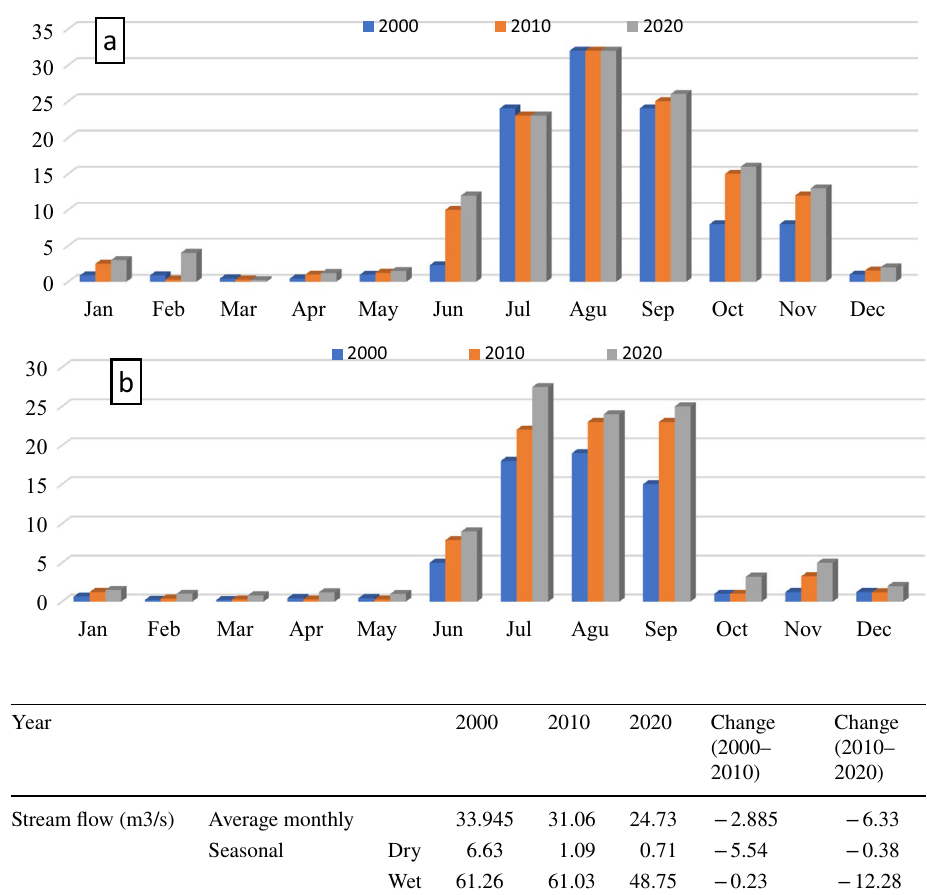
on average monthly and seasonal stream